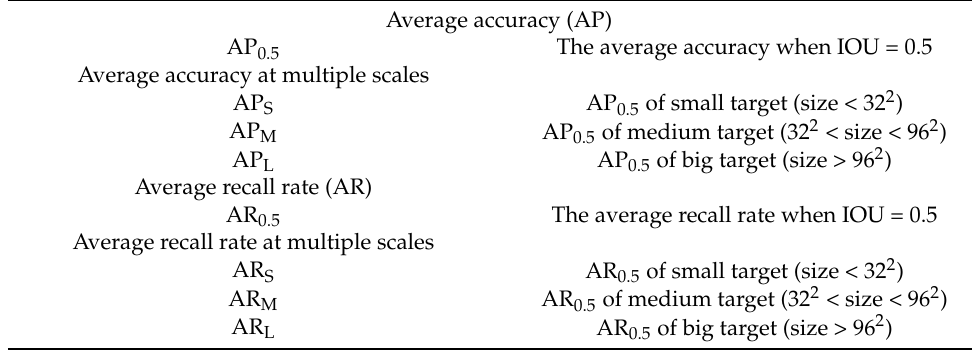
Table 5. Accuracy and recall under Microsoft COCO standard.